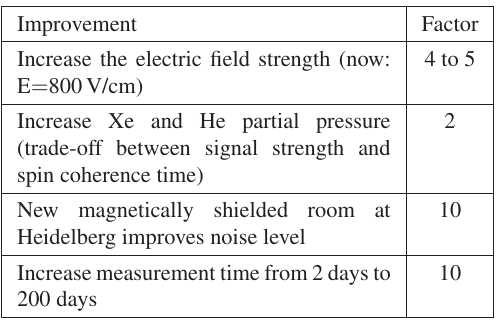
Table 2. Improvements we aim for within the next 5